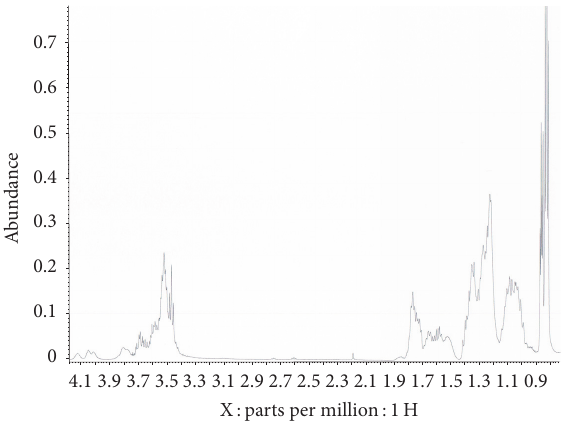
Figure 7: 1H-NMR spectrum of